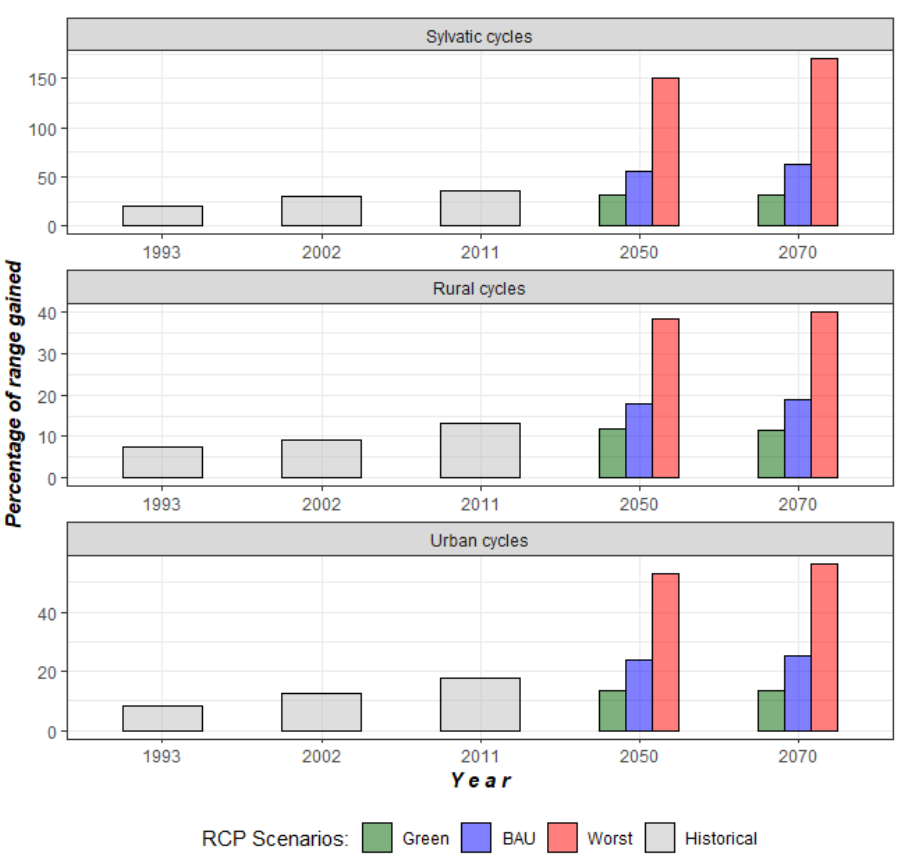
Figure 5. Percentage of range gained from historical LUCC-CC model (1985) to recent time-horizons (1993–2011) and for future distribution projections to 2050 and 2070, in each RCP scenario.